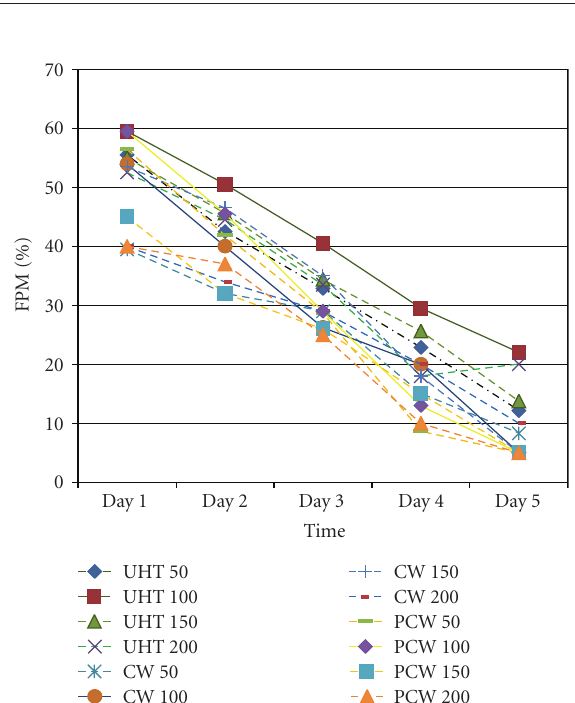
Figure 1: displays means and SD for FPM% for the various extenders at the various concentrations over